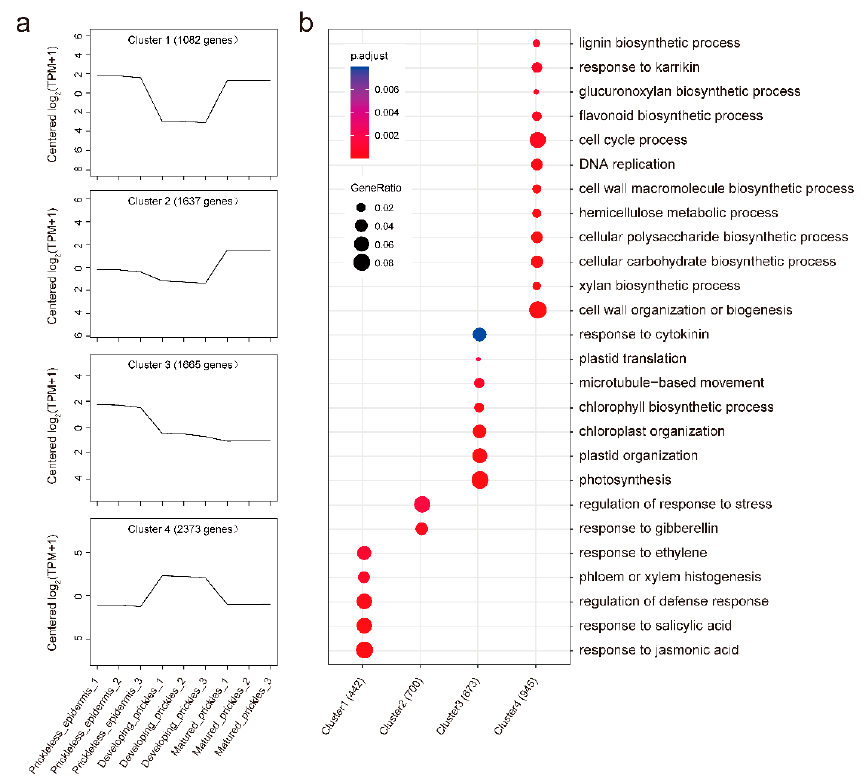
Figure 5. Expression patterns of DEGs during prickle development. ( a ) K-means clustering grouped DEGs into four clusters. ( b ) GO enrichment analysis among the four clusters using the ( b ) GO enrichment analysis among the four clusters using the